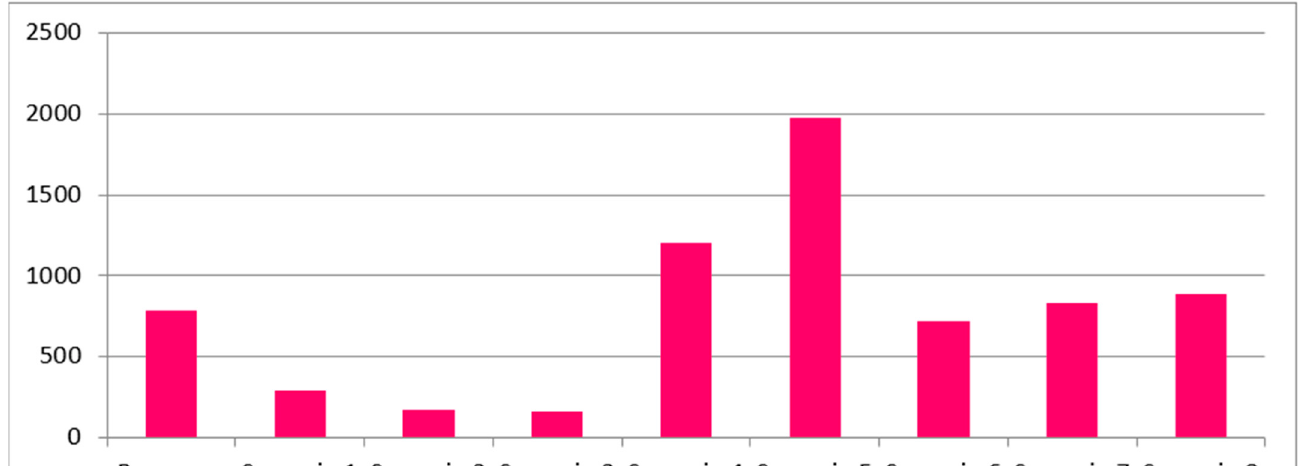
Figure 20. Unmet demand for base case and scenarios (MCM). Table 17. Yearly unmet demands (MCM).